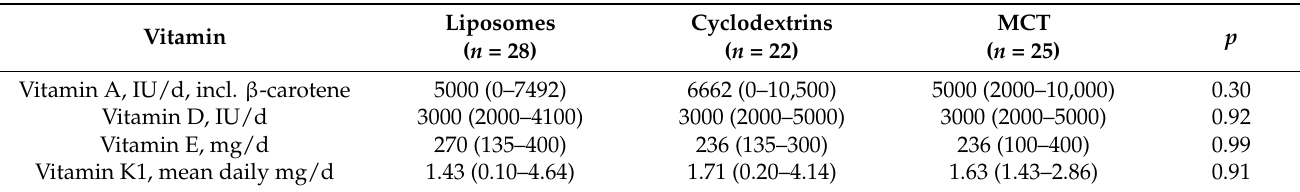
Table 3. Doses of fat-soluble vitamins in CF patients before the trial. Medians (1st–3rd quartiles) are shown along with the p -value for the Kruskal–Wallis test.